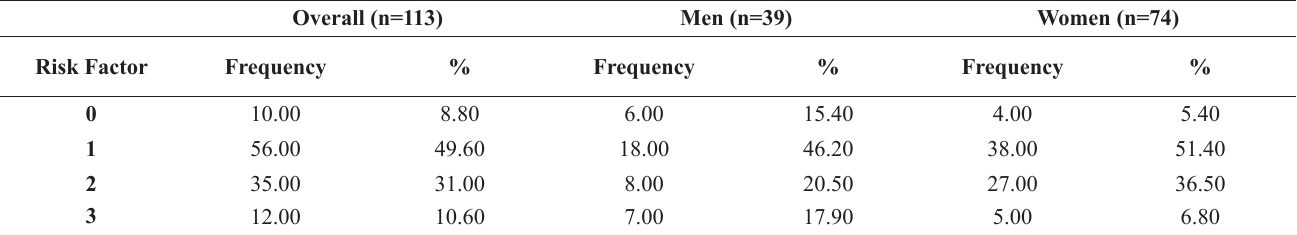
Table 3. Prevalence of Metabolic Syndrome in elderly aged 80 years and